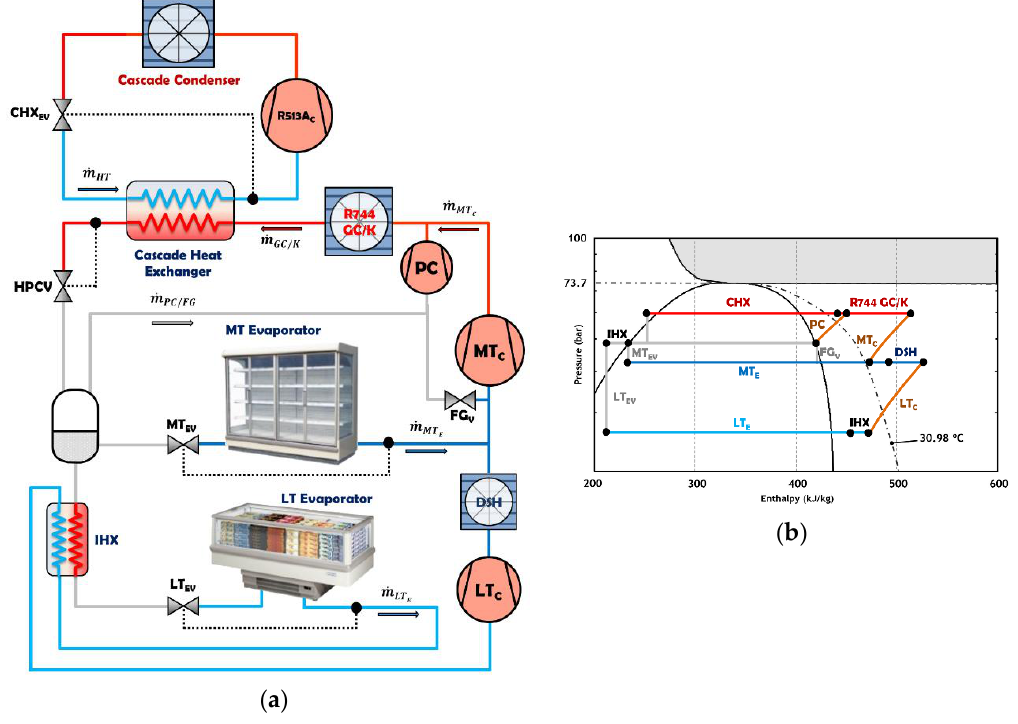
Figure 6. Schematic of a cascade with subcritical booster + PC ( a ) and its R744 p–h diagram ( b ).